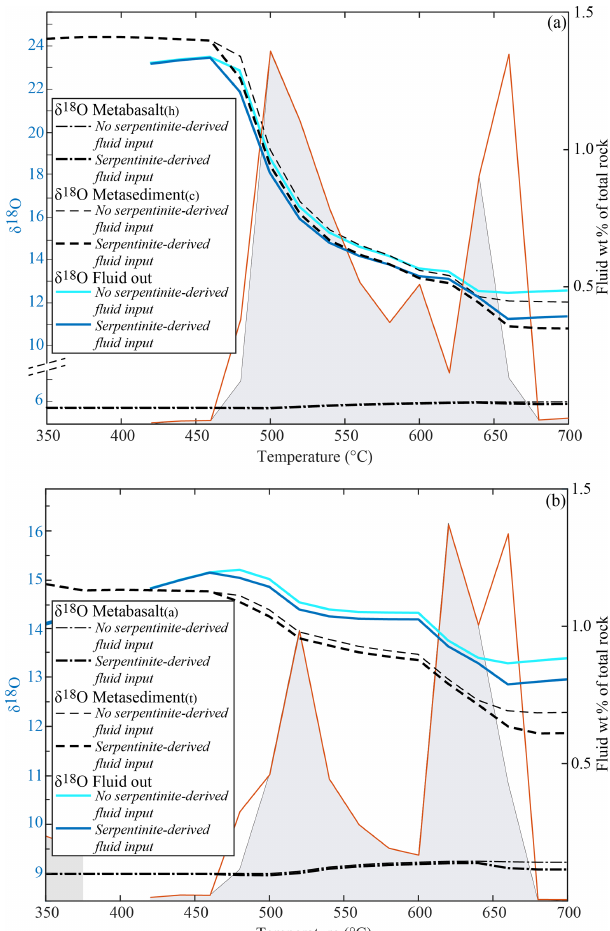
Figure 7. Double plot diagrams showing the effect of the fluid de- riving from a layer of 150m of pure serpentine (see text for details) on the δ 18 O of the rock types and of the of the total released H 2 O (left axis) and on the amount and distribution of the H 2 O released by the systems (right axis). All the values are calculated assuming HI between the metabasalts and the metasediments. Black dashed lines represent the bulk δ 18 O of the different lithologies and the blue lines the δ 18 O of the final fluid released by the systems. The final H 2 O released by each system is represented with a red line. The amount and distribution of the final fluids in the case of no serpentinite- derived fluid input (grey fields) are shown for comparison. (a) Mod- elled δ 18 O values and fluid amount for the system metabasalt ( h ) + metasediment ( c ) . (b) Modelled δ 18 O values and fluid amount for the system metabasalt ( a ) + metasediment ( t )